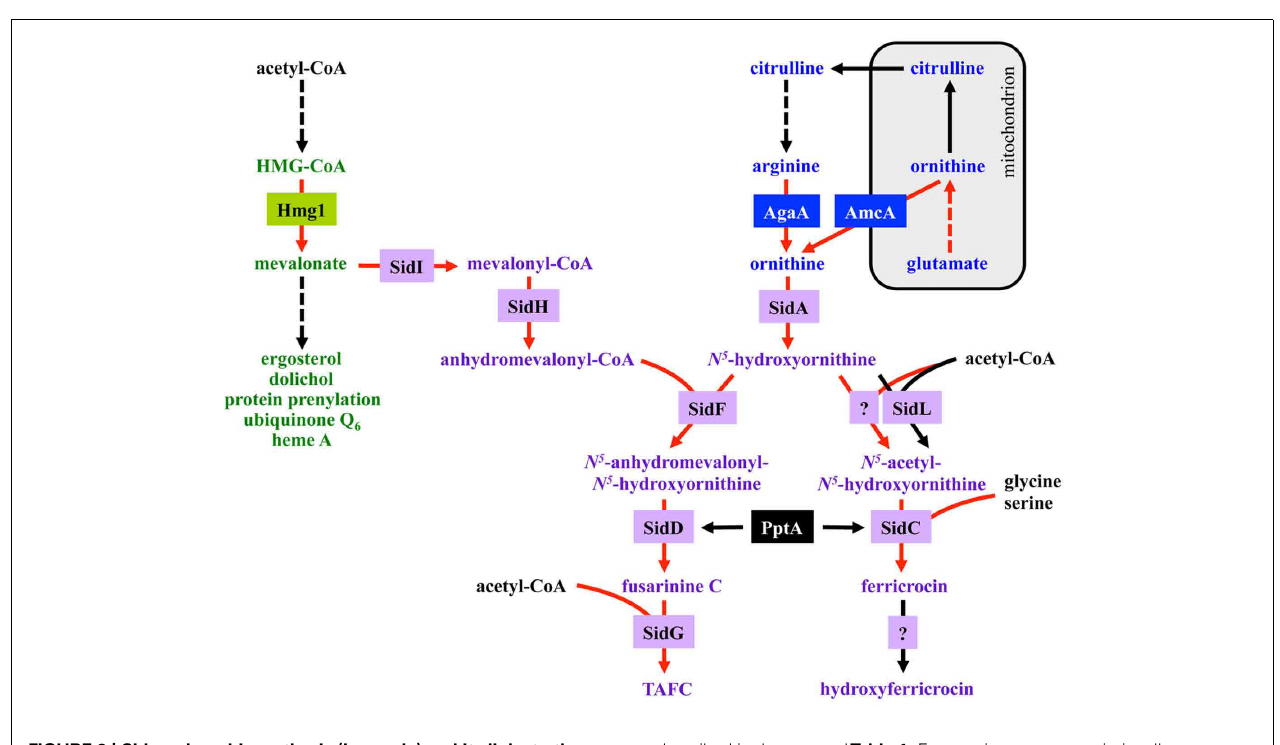
FIGURE 2 | Siderophore biosynthesis (in purple) and its links to the isoprenoid biosynthesis (in green) as well as ornithine/arginine metabolism (in blue). The enzymes, boxed in respective colors, are